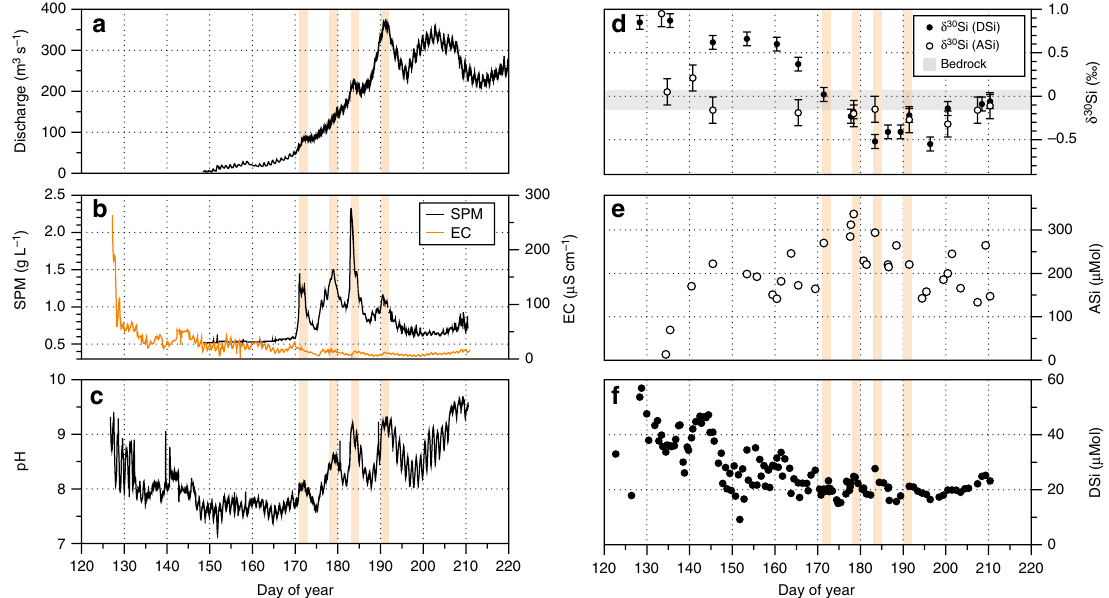
Fig. 2 Hydrological and geochemical time series from Leverett Glacier proglacial river. a Bulk meltwater discharge, b suspended particulate matter concentration (SPM) and electrical conductivity (EC), c continuous pH time series, d Si isotope composition ( δ 30 Si) of dissolved silica (DSi — closed symbols) and reactive amorphous silica (ASi — open symbols) with s.d., alongside suspended sediment and bedrock δ 30 Si range ( n = 7) in the shaded grey region, e ASi concentrations, and f DSi concentrations. The approximate timing of meltwater outburst events is marked with orange